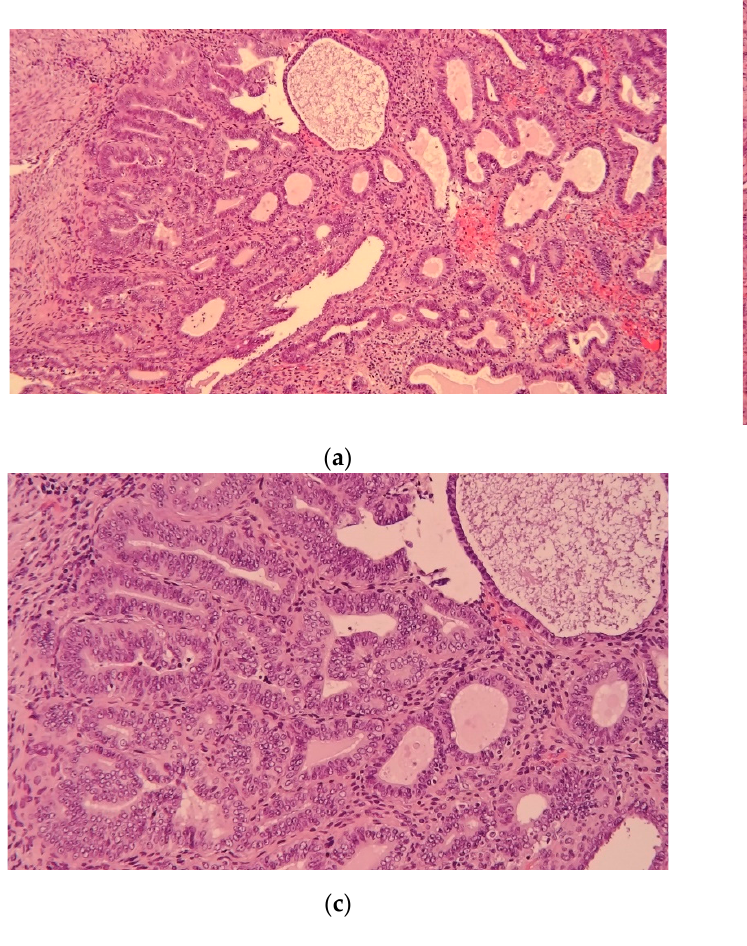
Figure 1. Histopathological images of atypical endometrial hyperplasia ( a – c ). The cases of malignancy were all represented by EC, with coexistent hyperplasia con ‐ firmed in 29 out of 53 women (54.7%). Twenty ‐ eight EC cases were histological grade 1